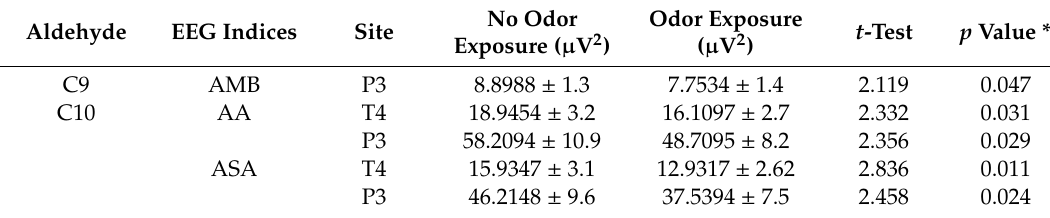
Table 1. Significant changes of electroencephalographic (EEG) power spectrum values during the binasal inhalations of aldehydes (C9 and C10).